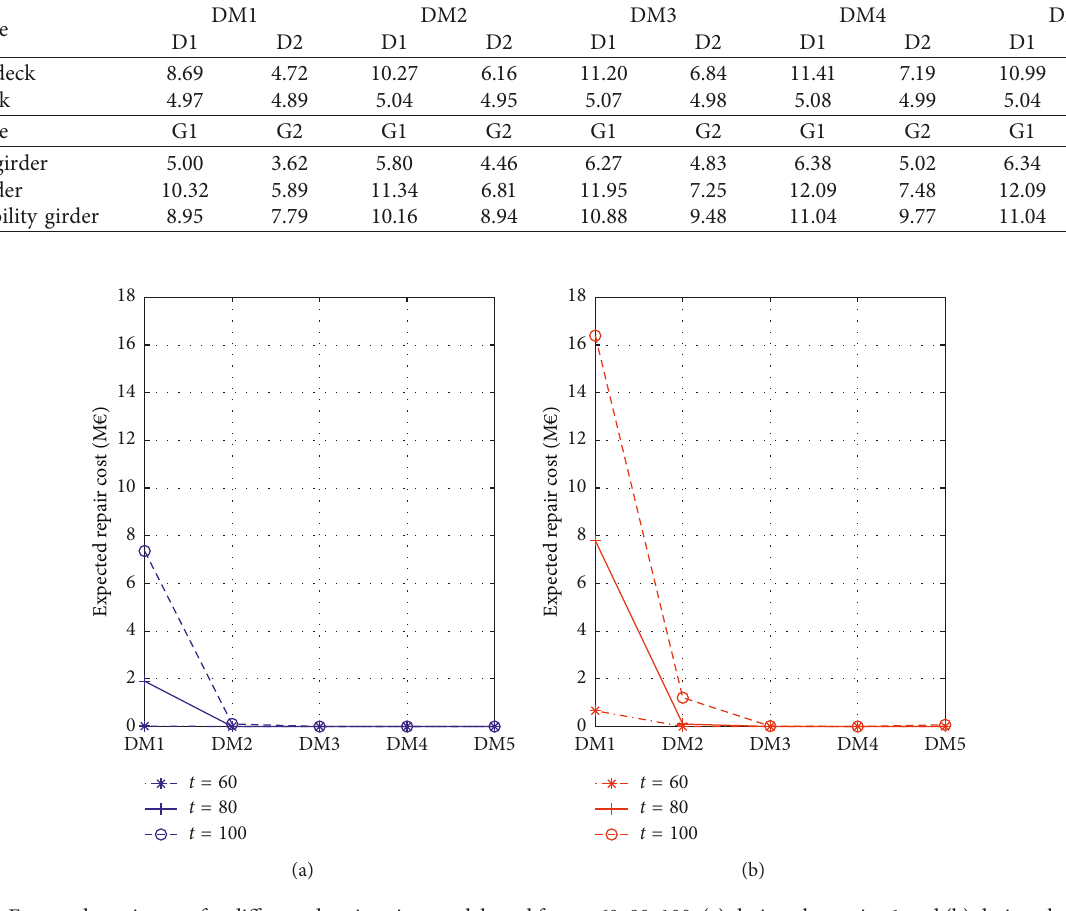
60, 80, 100: (a) design alternative 1 and (b) design alternative (cid:28)